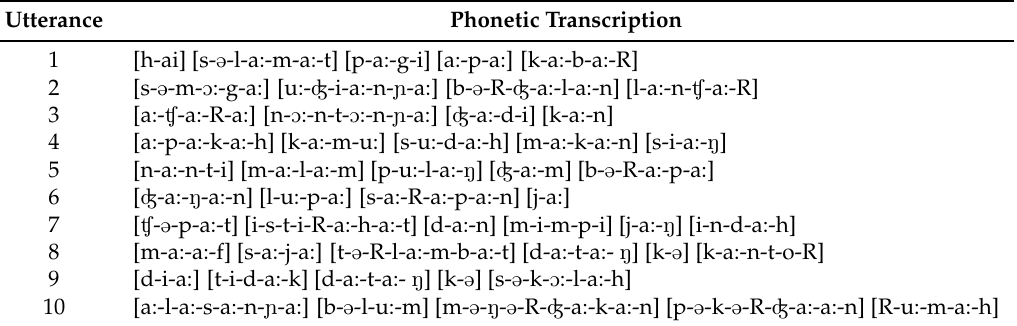
Table 1. The list of utterances used for the